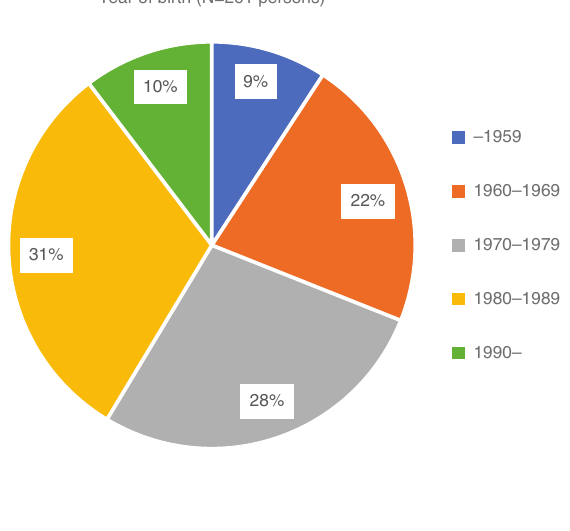
Fig. 1: Respondents by age groups (N=261